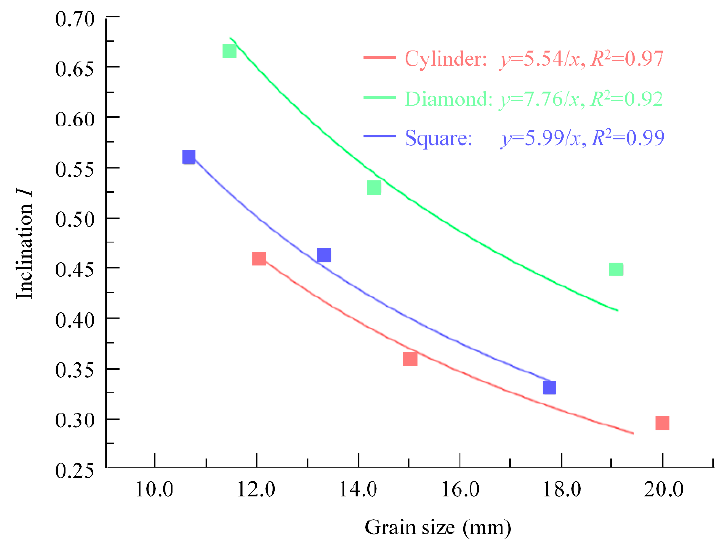
Figure 8. The relationship of inclination and aggregate size ( τ 0 = 23.55 Pa).